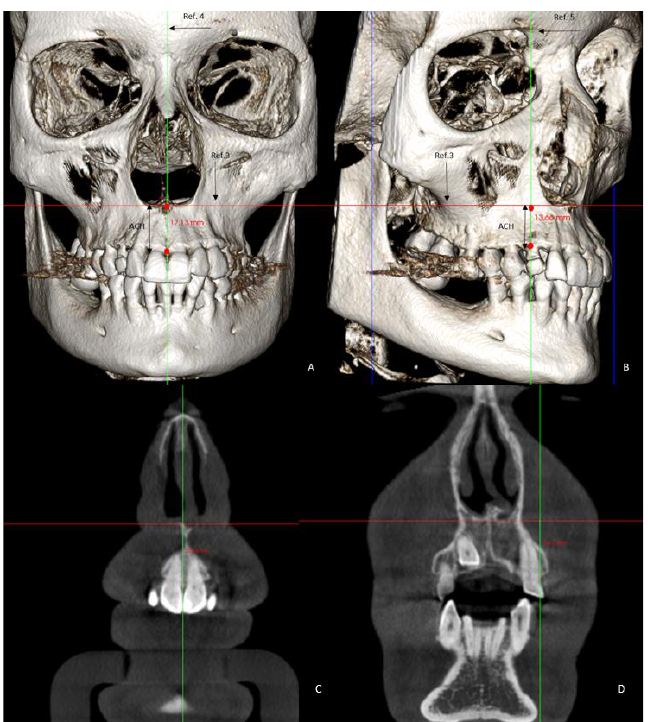
Figure 2. Images of the 3D measurements ( A , B ). CBCT reconstruction showing alveolar crest height (ACH) measured from the floor of the nasal fossa to the level of the crest measured between upper central incisors ( C ) and alveolar crest height per hemiarch (ACH ′ ) measured from the floor of the nasal fossa to the level of the crest measured at the level of the right and left canines ( D ). The dentoalveolar variables were as follows: